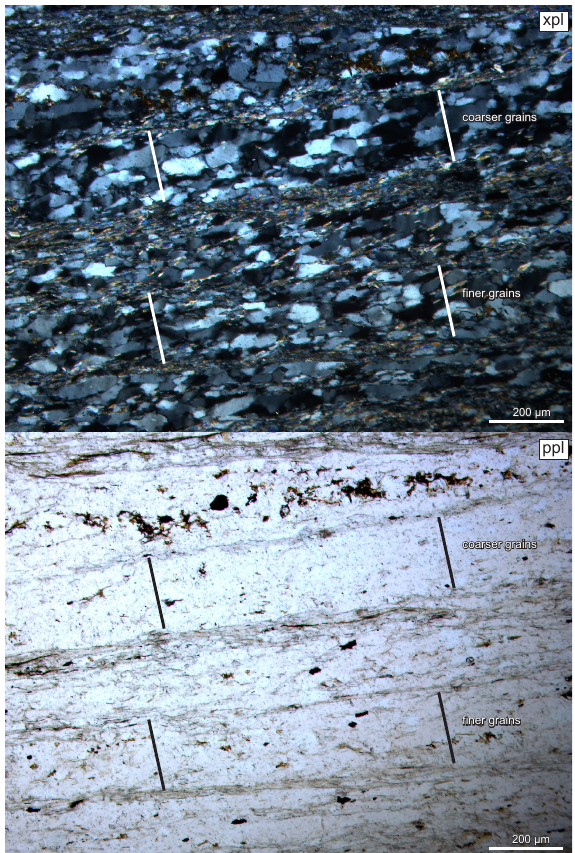
Figure 5. Cross-polarized (xpl) and plane polarized (ppl) photomi- crographs of the quartz-rich lens analysed in specimen S32. Lo- cation of photomicrographs is shown in Fig. 2d. The coarser- and finer-size portions are approximately the same thickness and quartz grains in both do not appear to be significantly affected by pinning of phyllosilicate